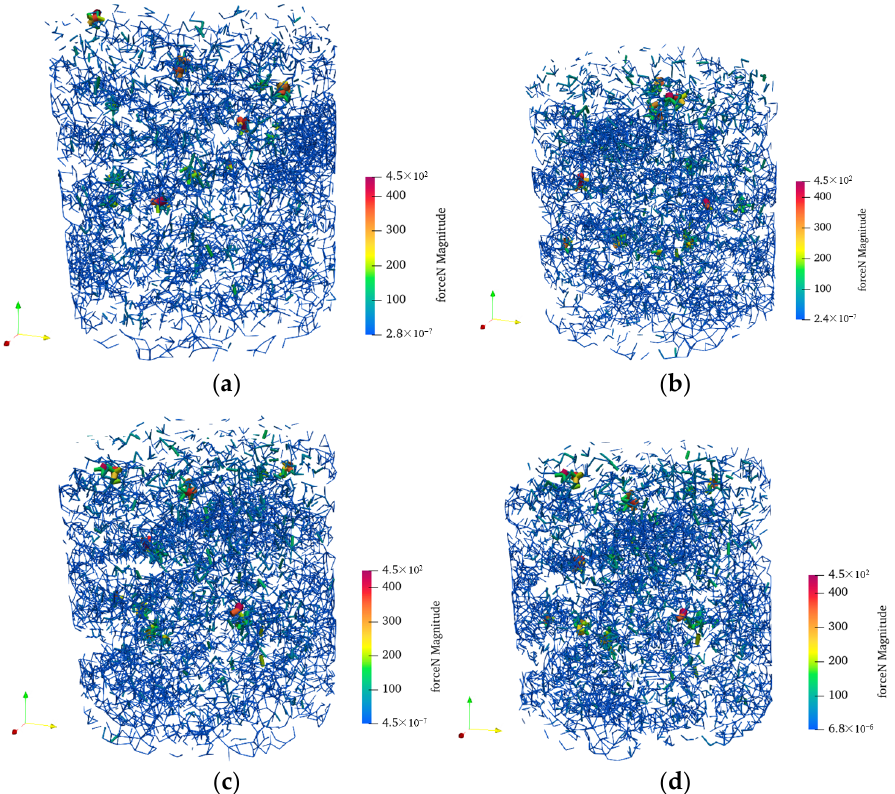
Figure 11. Normal contact force distribution under different compaction cycles: ( a ) 2 cycles; ( b ) 50 cycles; ( c ) 80 cycles; ( d ) 110 cycles.